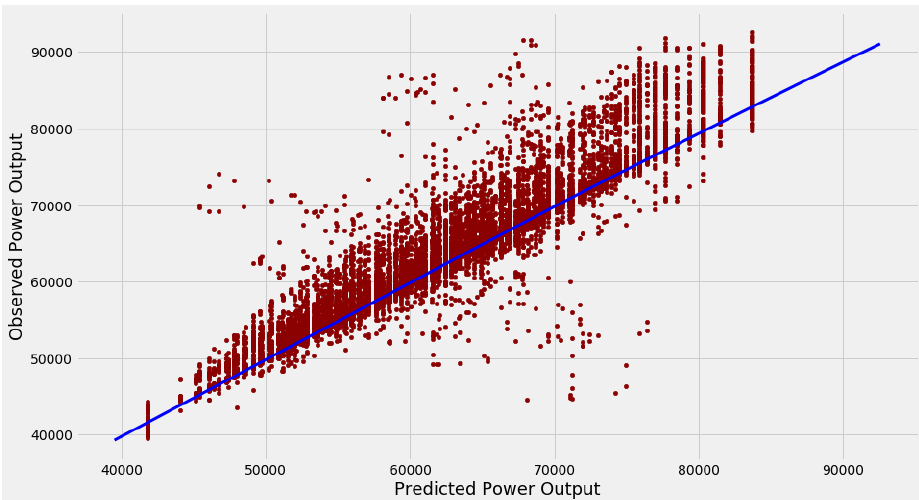
Figure 18. Scatter plot of predication v.s. test data.